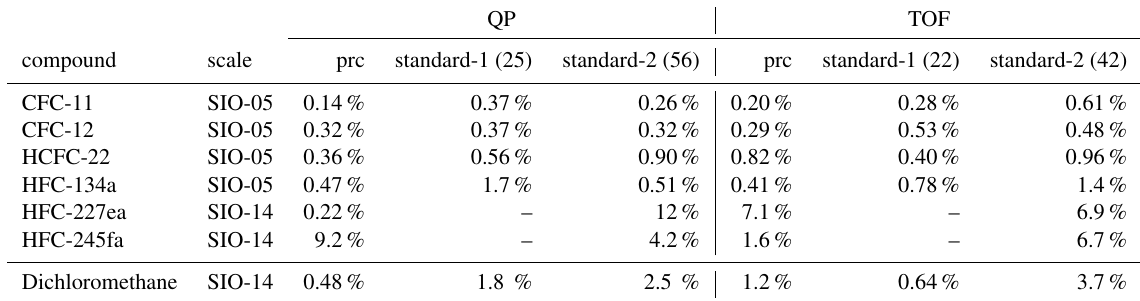
Table 2. System precision (prc, 1 σ ) in % for selected substances for detection with the quadrupole (QP) and the time-of-flight mass spec- trometer (TOF). The value of the system precision represents the best repeatability for the system as deduced from dedicated measurements. Precision for a particular measurement day can be different. Mixing ratios are reported as dry mixing ratios on SIO scales as listed in the first column. Columns labelled standard-1 and standard-2 contain long-term stability deduced from measurements of two primary standards used as targets. Numbers in brackets give the number of measurements available for the respective instrument. Listed are standard deviations of all precision filtered